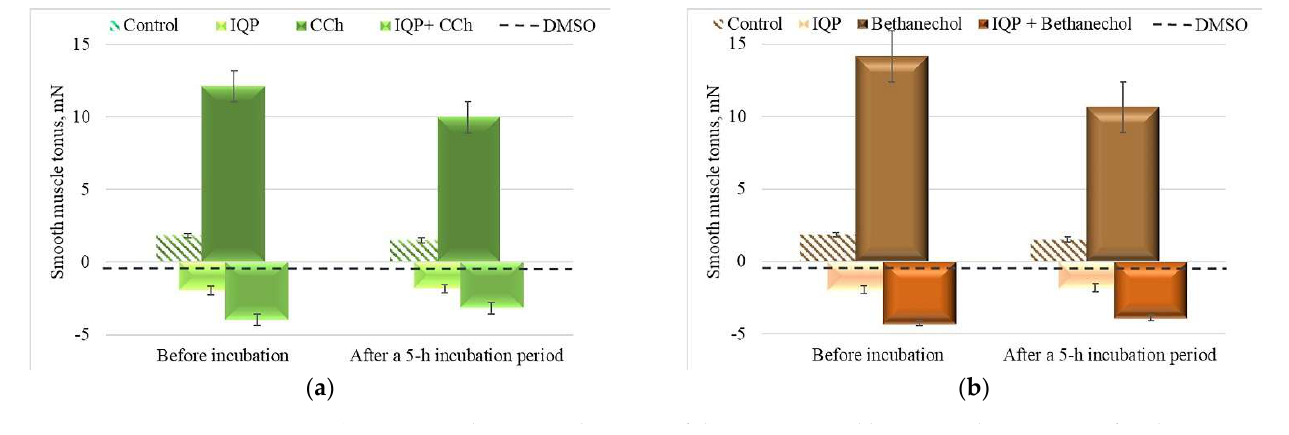
Figure 3. ( a ) Changes in the tonus of the SMPs caused by IQP in the presence of CCh (0.5 μM) ( p > 0.05; n = 13); ( b ) bethanechol (0.5 μM) ( p > 0.05; n = 13). The “-” sign indicates the SM relaxation ( p > 0.05; n = 13); ( b ) bethanechol (0.5 µ M) ( p > 0.05; n = 13). The “-” sign indicates the SM process. The solvent DMSO induced mild relaxation, the value of which was taken as the baseline for subsequent relaxation effects.